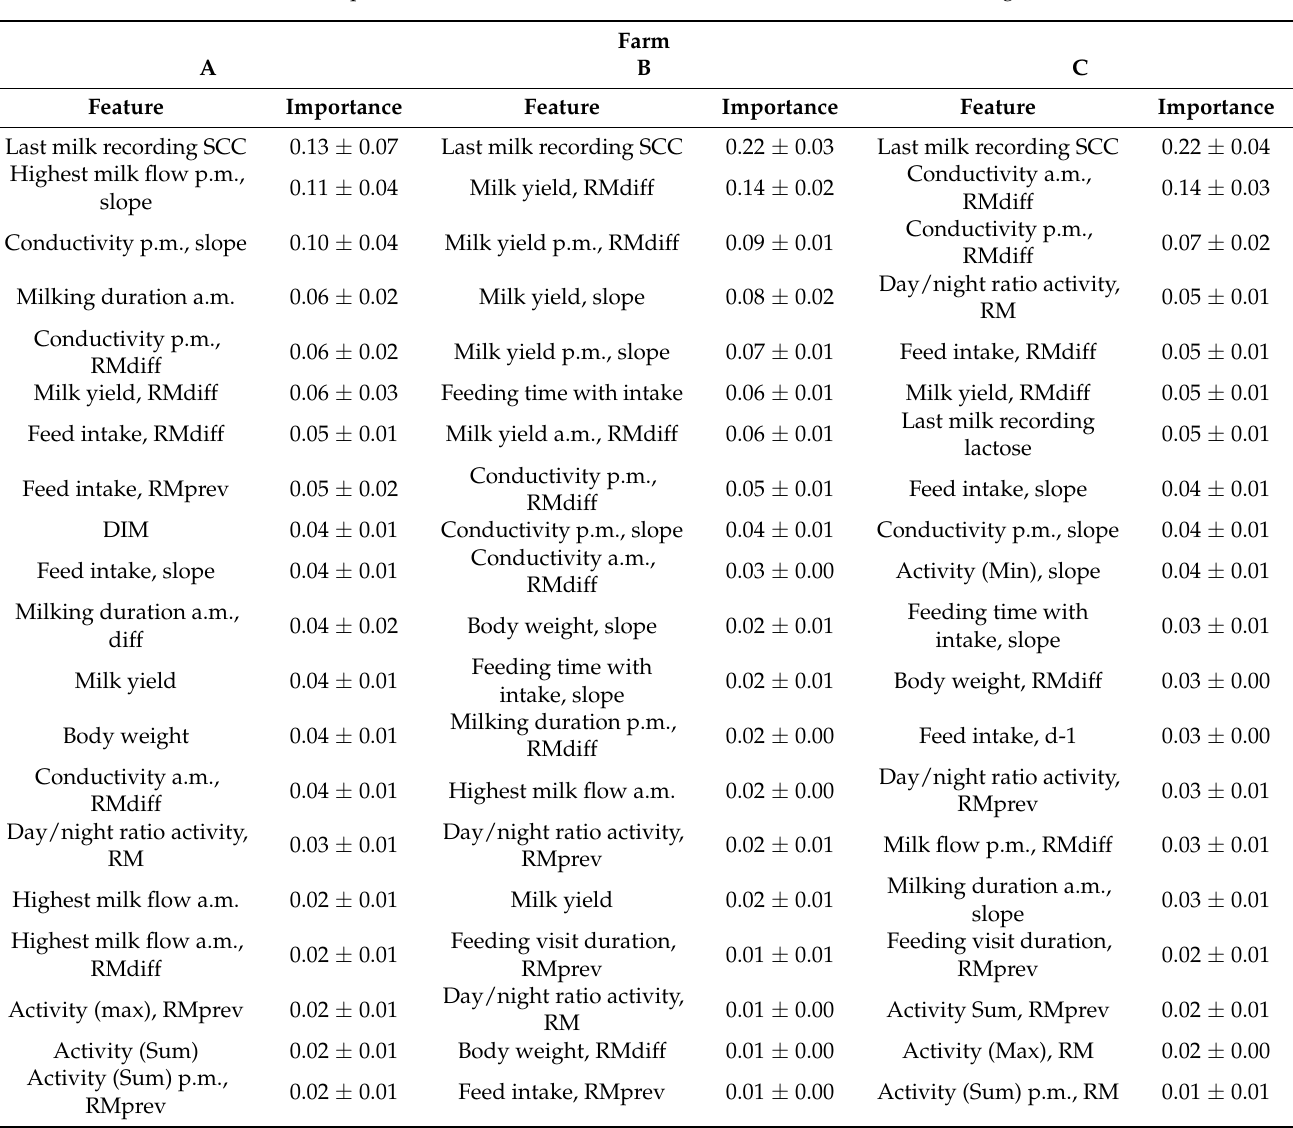
Table A1. Random Forest feature importance for mastitis treatments (Mean ± 95% CI), obtained during 5-fold cross